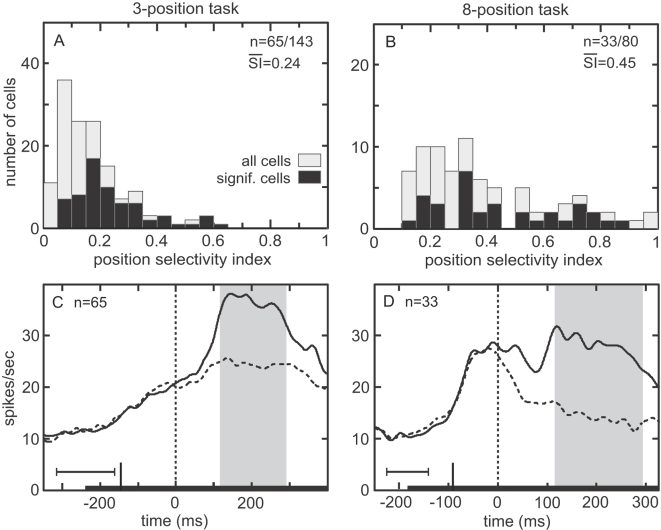
Eye position effect showing stimulus response changes as a function of gaze angle while stimulus remained foveally fixated.A. Distribution of position SI for 3-position task. B. Distribution of position SI for 8-position task. C. Time course of responses at best and worst eye positions in the 3-position task, averaged over all significant cells. Data included from most effective shape for each cell. Trials aligned on saccade (zero time). Gray zone indicates target fixation period, shifted by neural latency, the time epoch used for ANOVA. Horizontal error bar shows standard deviation of stimulus onset time. Long vertical tick mark indicates target onset shifted by neural latency. Curves smoothed using a 10 ms Gaussian kernel. D. Average time course at best and worst eye positions for 8-position task. Conventions are the same as in Figure 6C.